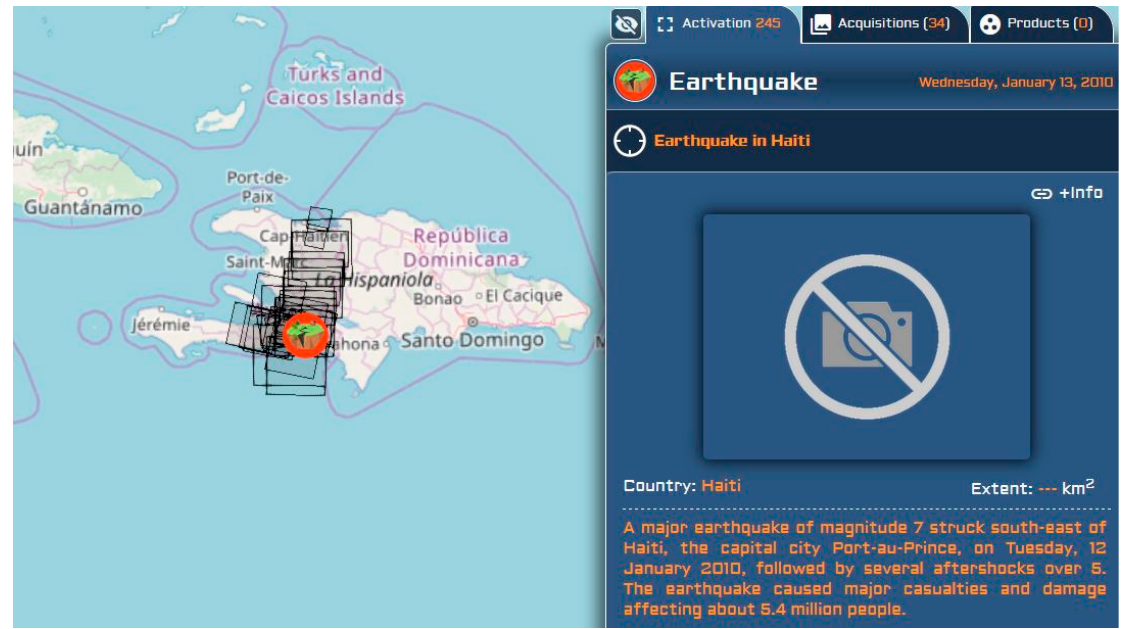
Figure 4. Charter activation, 13 January 2010: 34 images acquired over Figure 4. International Charter activation, 13 January 2010: 34 images acquired over Port-au-Prince.